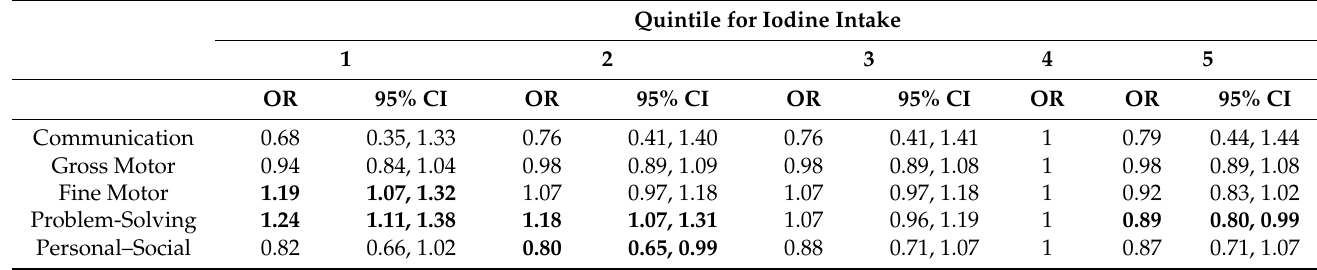
Table 2. Adjusted ORs and 95% CIs for child neurodevelopmental delay at 1 year of age based on maternal iodine intake in multiple binomial logistic regression